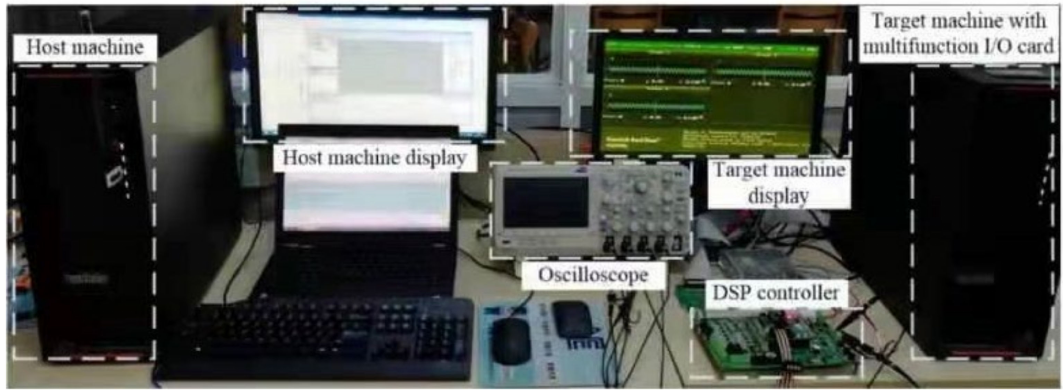
Figure 13. RT-LAB test platform.